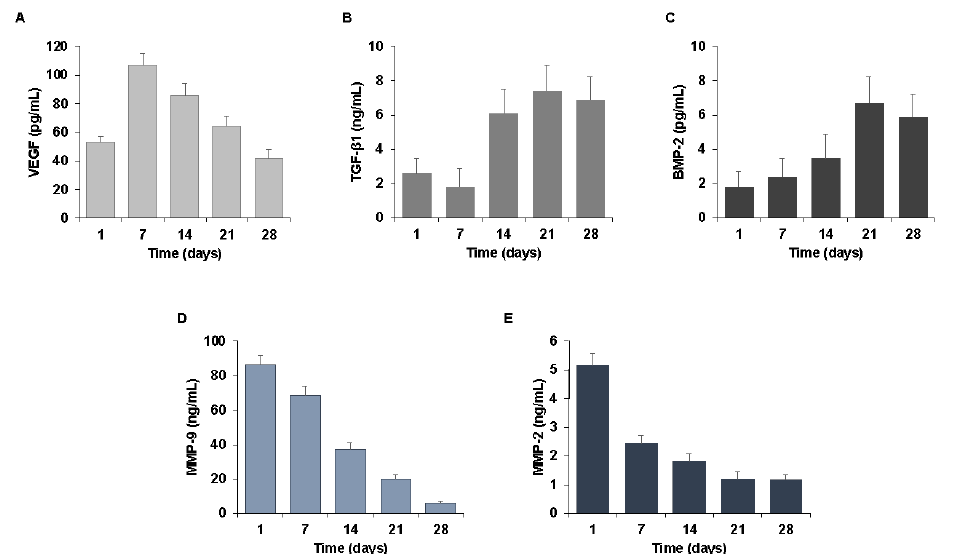
Figure 2. Growth factors and matrix metalloproteinases released by CGF-coated implants. Implants permeated with CGF were incubated in cell culture medium for a period of 0–28 days. At the indicated times (1, 7, 14, 21, and 28 days), the conditioned media were collected. The growth factors ( A ) VEGF, ( B ) TGF- β1, ( C ) BMP-2, the matrix metalloproteinases ( D ) MMP-9, and ( E ) MMP-2 were quantified by ELISA. The results are expressed as the means ± SD of triplicate measurements from three independent experiments.